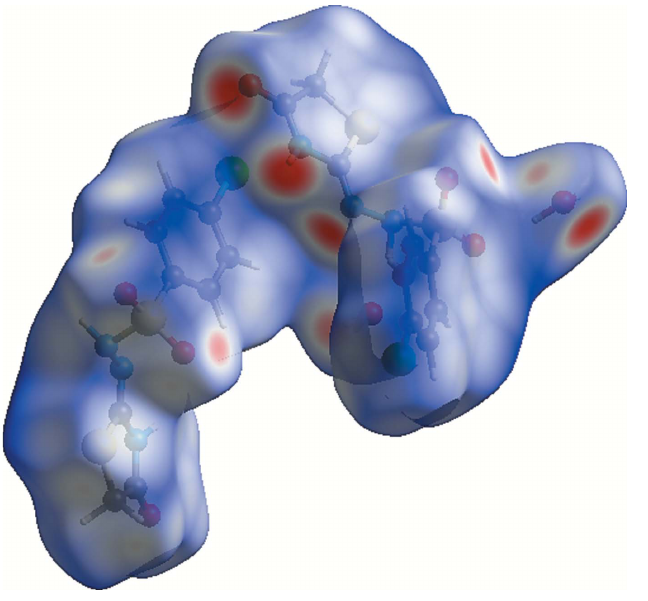
Figure 3 View of the Hirshfeld surface mapped over d norm .